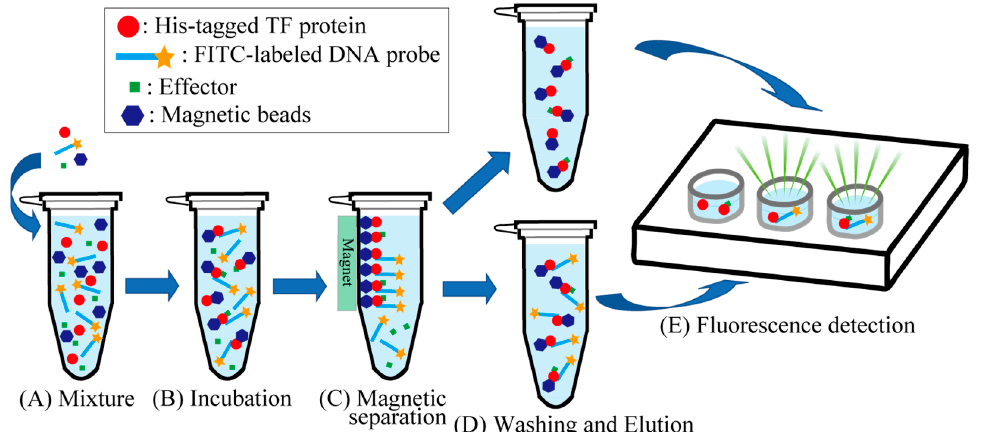
Figure 2. Magnetic bead assay for the detection of promoter DNA and transcription factor (TF) in the presence of metal ions. ( A ) Magnetic beads, a DNA probe, and a His-tagged TF (and effector) were added to MagneHis Binding Buffer. ( B ) The mixture was incubated at room temperature (20–24 ◦ C) for 2 min. ( C ) The magnetic beads were attracted using a magnet. ( D ) The supernatant was removed using a pipette, and MagneHis Wash Buffer was added to the tube. MagneHis Elution Buffer was added after removing the supernatant. ( E ) The eluate was transferred to a plate, and the fluorescence of the solution was analyzed using a laser